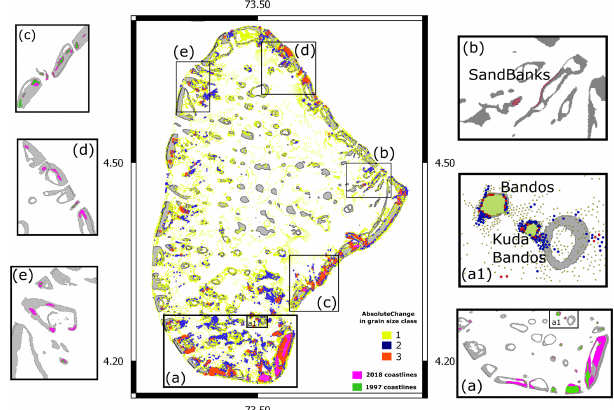
Figure 8. Absolute difference in bed sediment grain class predicted to have occurred between 1997–2018 due to changes in coastline. Spots coloured “yellow”, “blue” and “red” are used to mark loca- tions where an absolute grain size change of 1, 2 or 3 classes has occurred. Panels (a) – (f) show some of the examples of changes to coastlines which have occurred from 1997 to 2018. Panel (a1) is a close-up of a region shown in (a) showing increased erosion in Kudabandos. Panel (b) shows the natural formation of sand banks in lagoons which is also predicted to contribute to grain size changes in the atoll basin. The boundaries of reef lagoons (Spalding et al., 2001) are shown in grey for better visualisation. Generally large changes are predicted in the areas where coastline changes have oc- curred, but change in grain size is also observed across the wider atoll